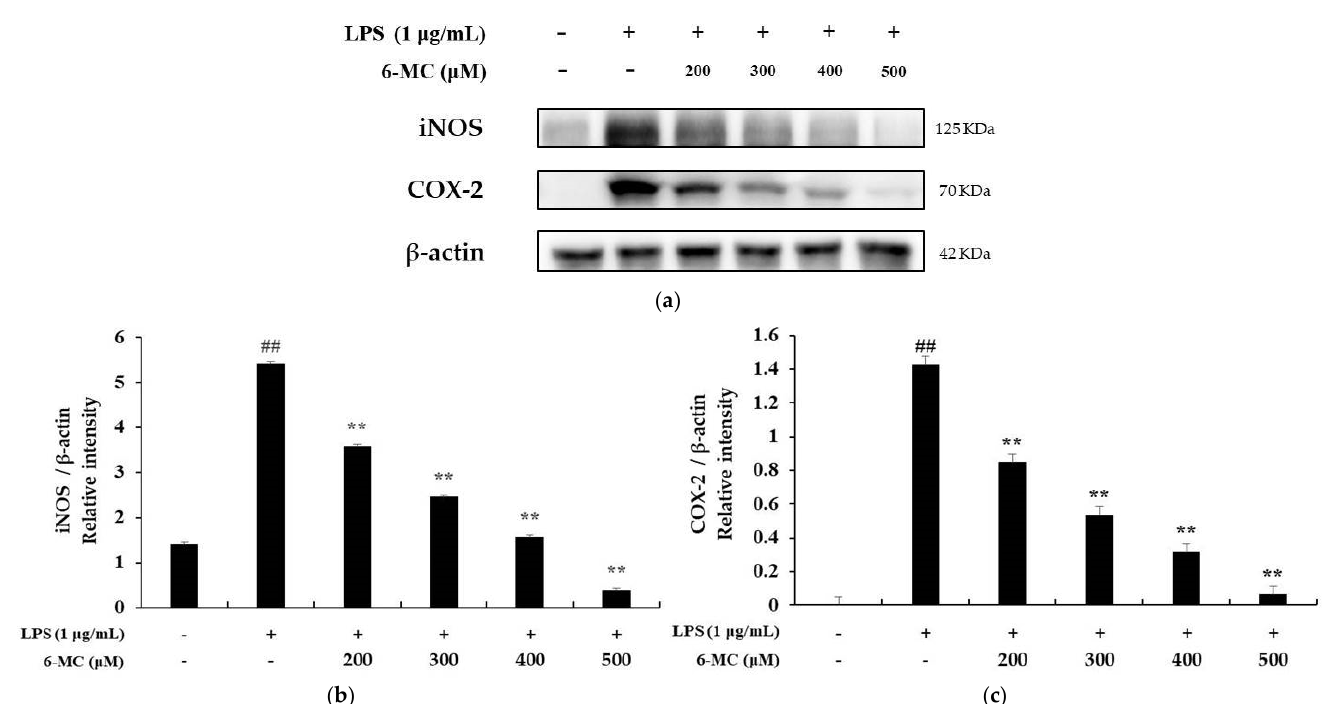
Figure 5. Effect of 6-MC on the protein expression level of iNOS and COX-2 in LPS-induced RAW 264.7 cells. ( a ) Result of Western blotting, and protein levels of ( b ) iNOS and ( c ) COX-2. Lysates were prepared from cells pretreated with 6-MC (200, 300, 400, and 500 μM) for 1 h and then treated with LPS (1 μg/mL) for 18 h. β-actin was used as a loading control. Total cellular proteins were separated using SDS-PAGE, transferred to PVDF membranes, and detected using specific antibodies against iNOS, COX-2, and β-actin. The results in the graphs are presented as the mean ± SD from three independent measurements using the ImageJ program. ## p < 0.01 vs. untreated control group. ** p < 0.01 versus group treated with LPS alone.